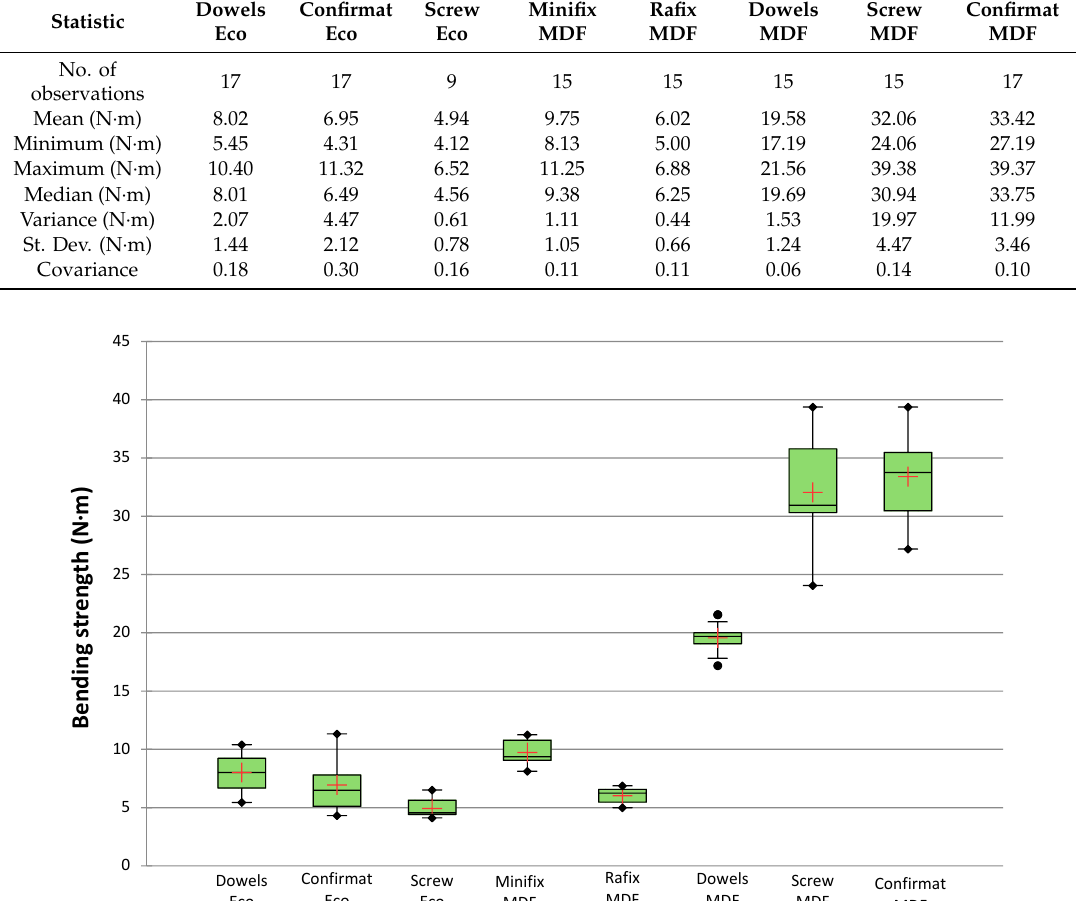
Table 3. Tukey honestly significant difference (HSD) analysis of the differences between the groups with a confidence interval of 95% of the bending capacity of joints of two materials of all pairwise comparisons.